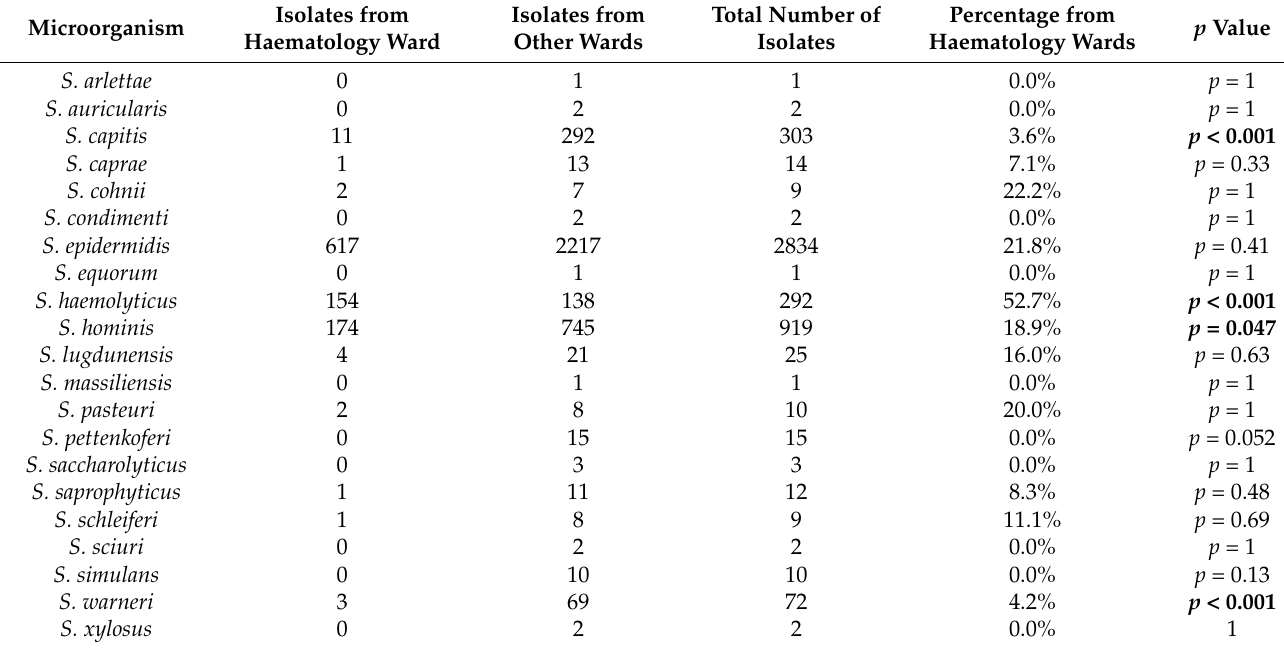
Table 3. CoNS isolates found in the participating university hospital, comparing the number of first isolates found in Haematology wards vs. other